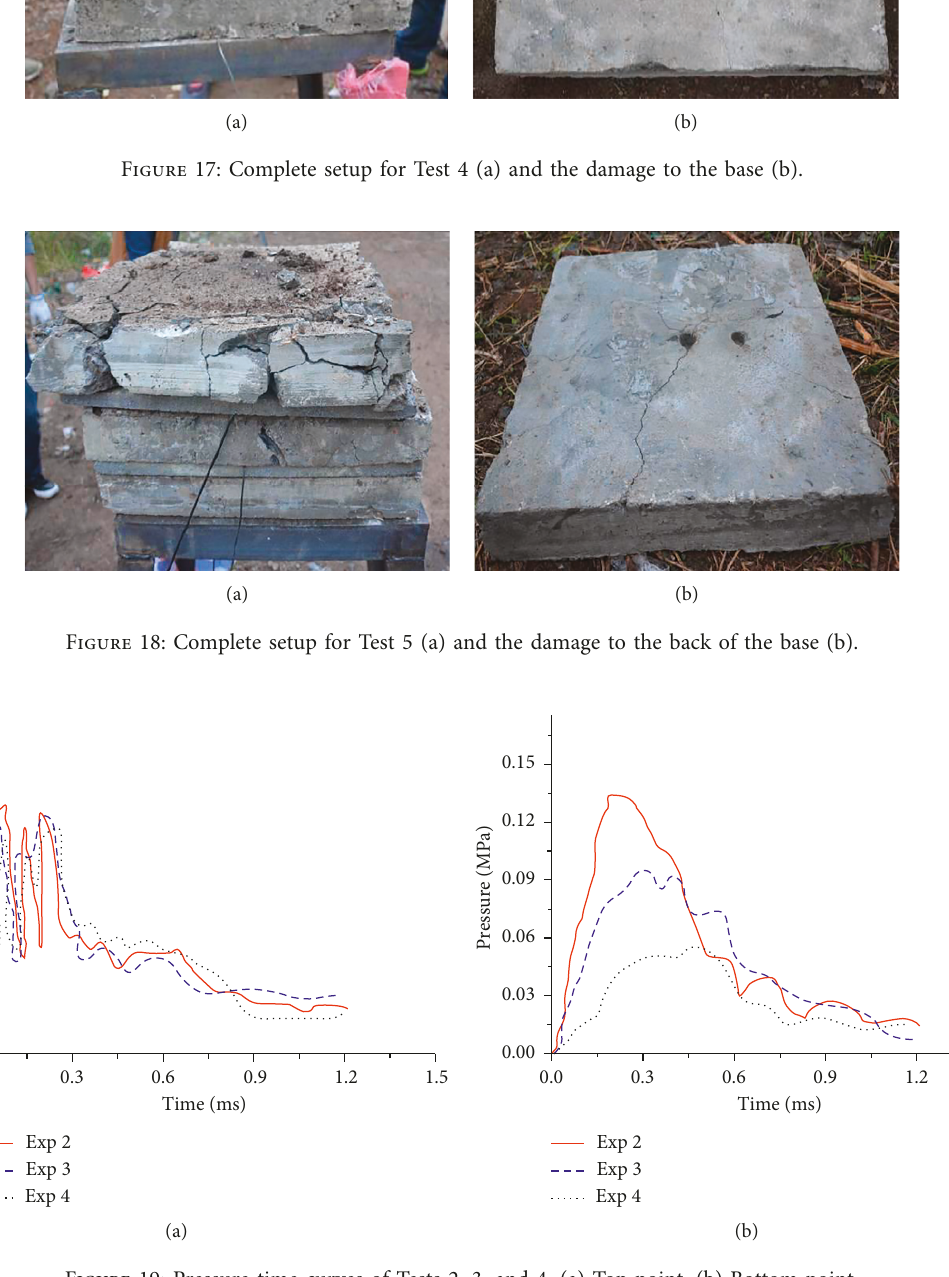
Figure 19: Pressure-time curves of Tests 2, 3, and 4. (a) Top point. (b) Bottom